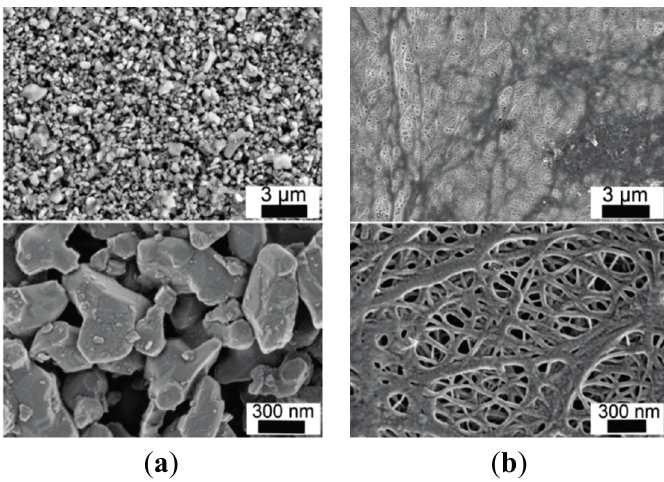
Figure 5. Scanning electron microscopy (SEM) picture of the surface of separator COD-20 ( a ) and COATED ( b ).